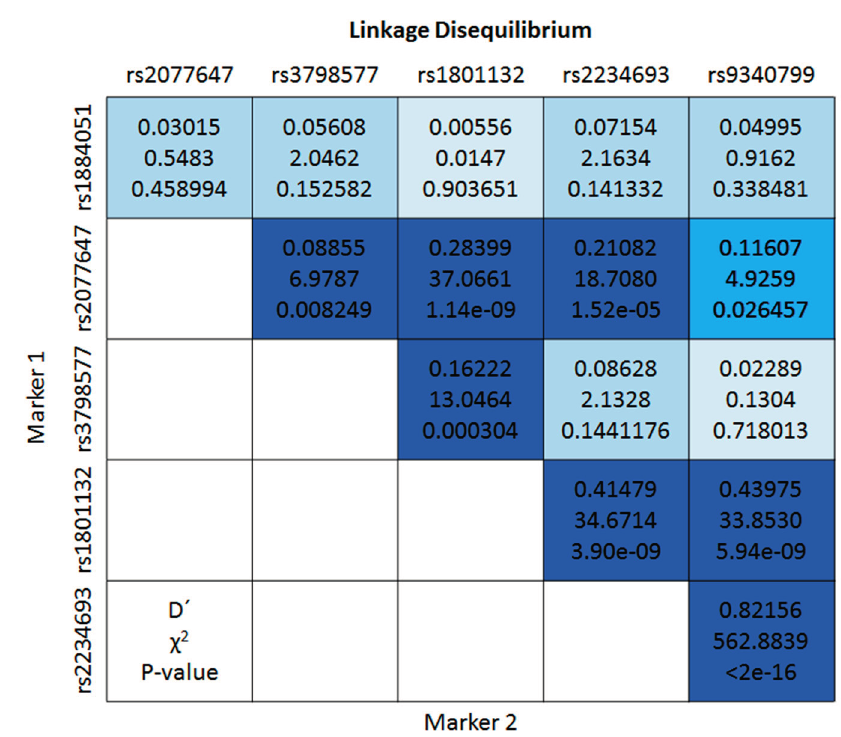
Figure 1. Map of linkage disequilibrium (LD) between the SNPs of the ESR1 gene. The figure provided the statistics employed to determine the LD. The highest LD is indicated by navy blue ( p < 0.0001 or p < 0.01), low disequilibrium show in medium blue ( p < 0.05) and not significant in light blue ( p >